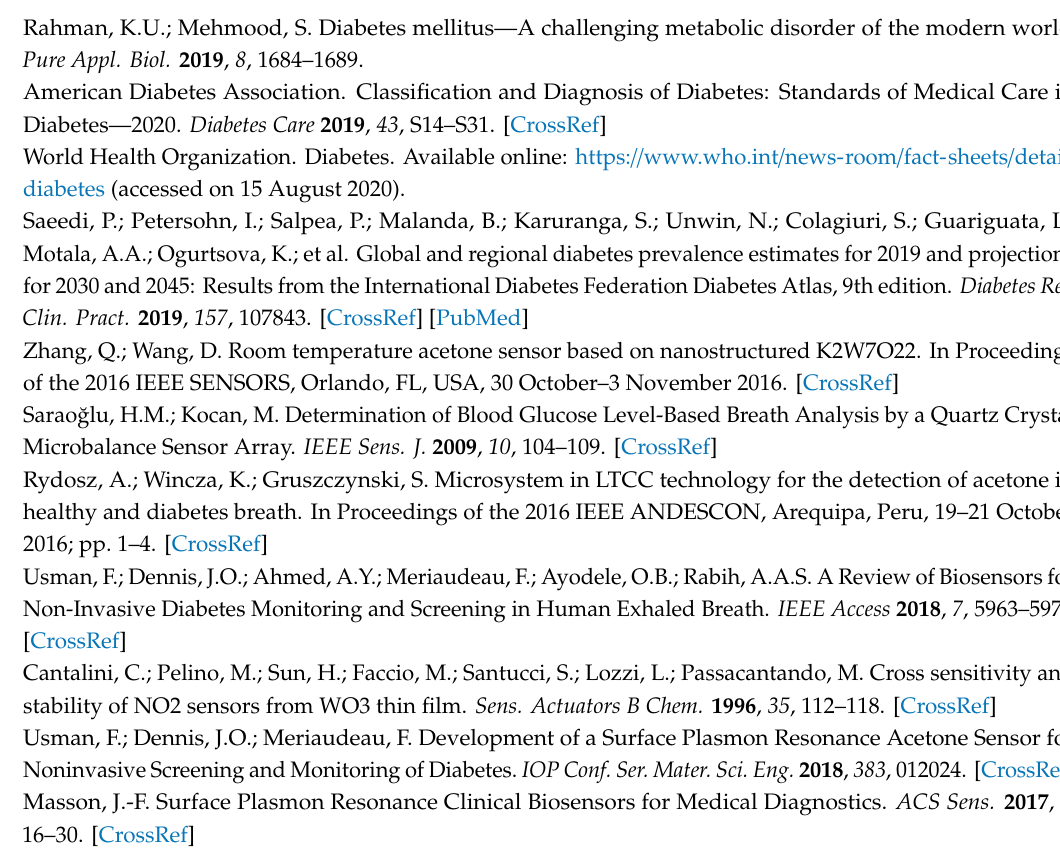
Figure S1: Picture of the experimental SPR setup. Table S1: Data for the chitosan-PEG-based SPR sensor. Figure S2: AFM images of glass, gold, and chitosan-PEG surfaces. Figure S3: Thickness of gold thin film deposited at 20 mA, 67s estimated using a (a) surface profiler and (b) surface roughness tester. Figure S4: (a) SPR curves of di ff erent layers of the chitosan-PEG-based SPR sensor, (b) SPR angle shift versus the acetone concentration. Figure S5: Blank SPR response. Table S2: Blank sample response, Langmuir and Freundlich adsorption equations (Equations (S1)–(S4)). Table S3: Assignment of the C1s, O1s, N1s, and S2p peaks for the chitosan-PEG thin